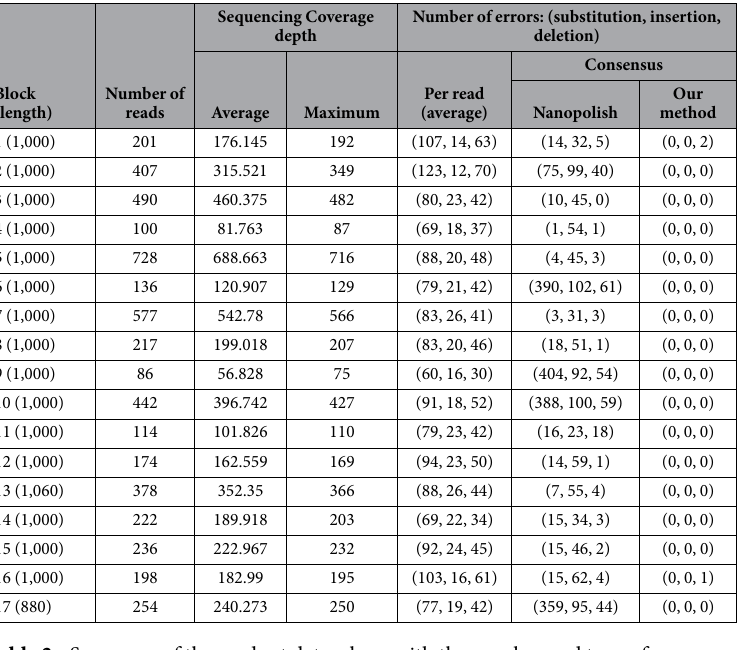
Table 2. Summary of the readout data, along with the number and type of errors encountered in the reads.